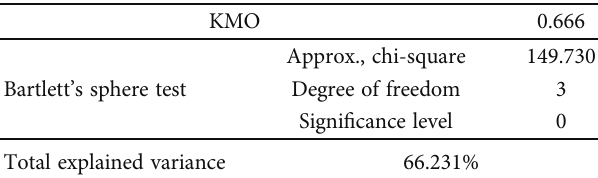
Table 4: Customer perceived value KMO and Bartlett ’ s text test